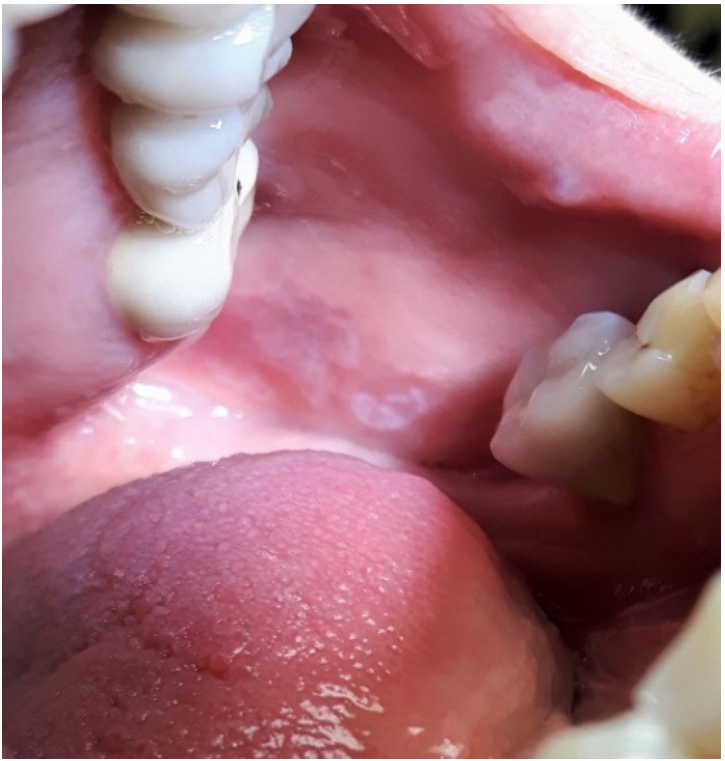
Figure 3. Aspect of the OLP at 6 weeks of PBM treatment. The erosive area and pain have disappeared. A slight reduction in the size of the lesion may be